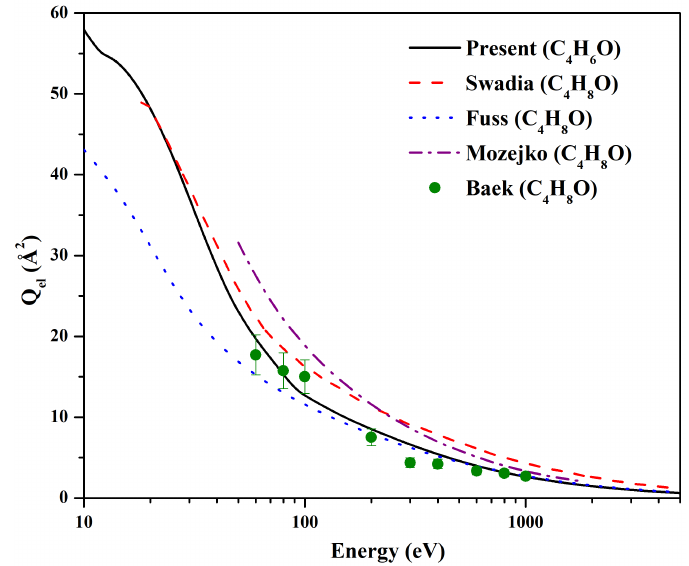
Figure 3. Q el for furan, 2, 5-dihydro. Solid line: present Q el ; dash line: Q el for THF by Swadia et al. [13]; dotted line: Q el for THF by Fuss et al. [18]; dash-dot line: Q el for THF by Moze- jko et al. [14]; solid circle: Q el for THF by Baek et al. [19].